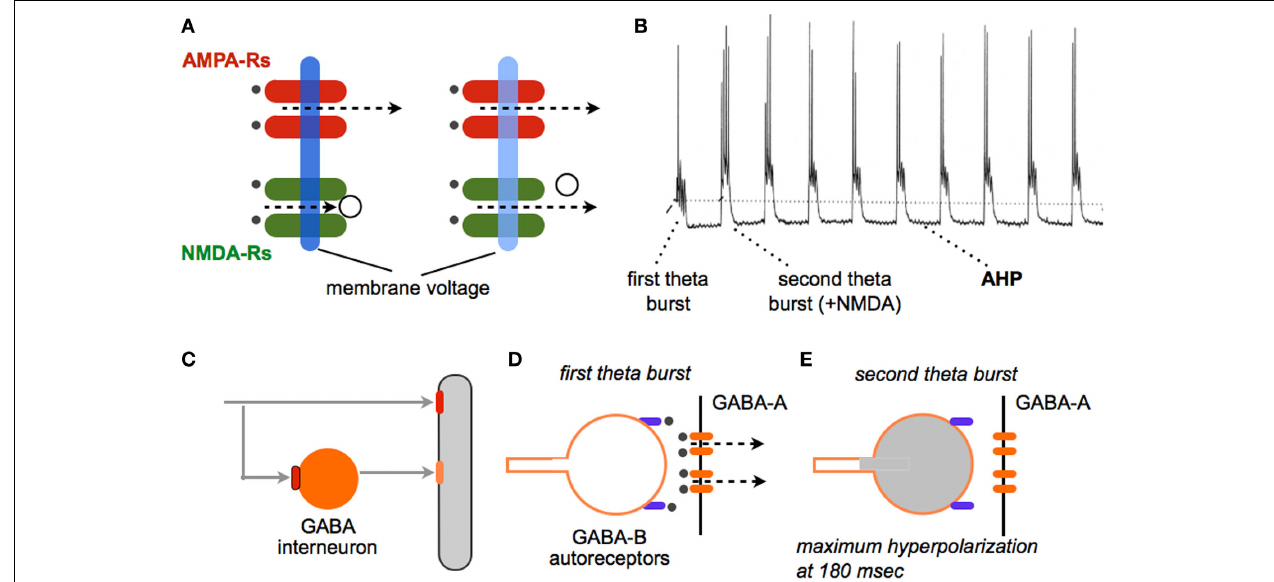
FIGURE 1 | Why theta burst stimulation (TBS) is so effective at inducing LTP. TBS (Larson et al., 1986) mimics a firing pattern found in cortical neurons during learning (Otto et al., 1991) and elicits a robust, non-decremental LTP that persists for weeks (at least). (A) (left side). A single stimulation pulse releases glutamate (black dots) and a partial membrane depolarization via current flux through AMPA receptors (dotted line). NMDA receptors do not open because of voltage dependent block of the ion channel (open circle). (right side) Trains of high frequency stimulation cause a greater depolarization (light blue) that removes the channel block and thereby allows current flow through calcium permeant NMDA receptors. Calcium is the initial trigger for LTP. (B) Intracellular recording shows that the first theta burst (four pulses at 100Hz) in a train causes a relatively modest depolarization accompanied by a single spike; NMDA receptors make a very small contribution to this response. A second burst administered after a delay corresponding to the period of the theta wave produces a more profound depolarization with multiple spikes; this burst response contains a large NMDA receptor mediated component. Note that each theta burst in the train is followed by a large